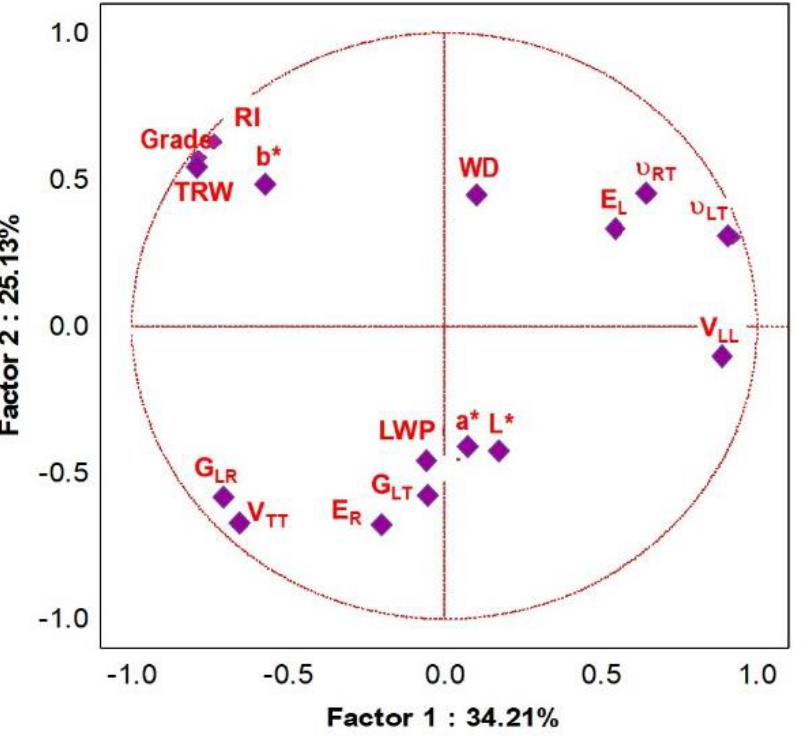
Figure 8. The physical, acoustic, and elastic parameters in the 1,2 plane of the PCA. Legend: grade, the quality class of resonant spruce wood; RI, the ring width regularity index; TRW, the annual ring width; b* , color yellowness; WD, wood density; E L , Young’s modulus along the wood fibers; υ RT and υ LT , Poisson coefficients; V LL , sound velocity in the longitudinal direction of the wood (along the grain); a* , redness color; L* , brightness color; LWP, late wood proportion; G LT and G LR , shear moduli; V TT , sound velocity in the tangential direction of wood; E R , Young’s modulus in the radial direction of wood.